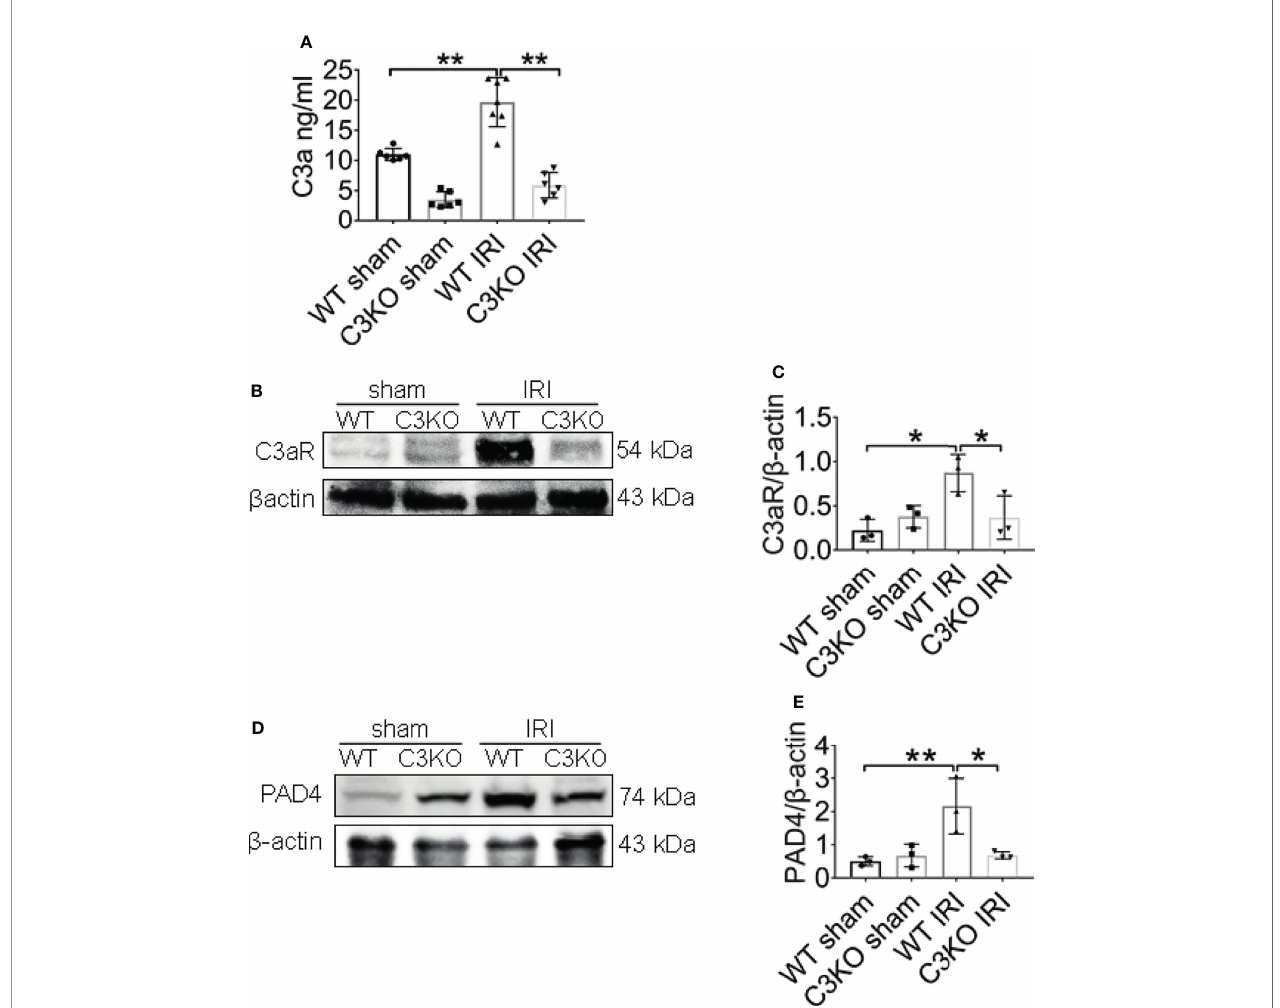
FIGURE 8 | C3a is an important molecule in IRI. (A) Renal levels of C3a from WT and C3KO mice, measured by ELISA. (B) Immunoblotting analysis of C3aR expression in mouse kidneys 24 h after IRI. (C) Quantitative analysis was analyzed by normalization to b -actin expression, n = 3/group. (D) Immunoblotting analysis of PAD4 expression in mouse kidneys 24 h after IRI. (E) Quantitative analysis was analyzed by normalization to b -actin expression, n = 3/group. *P < 0.05, **P < 0.01. Data are presented as mean ±